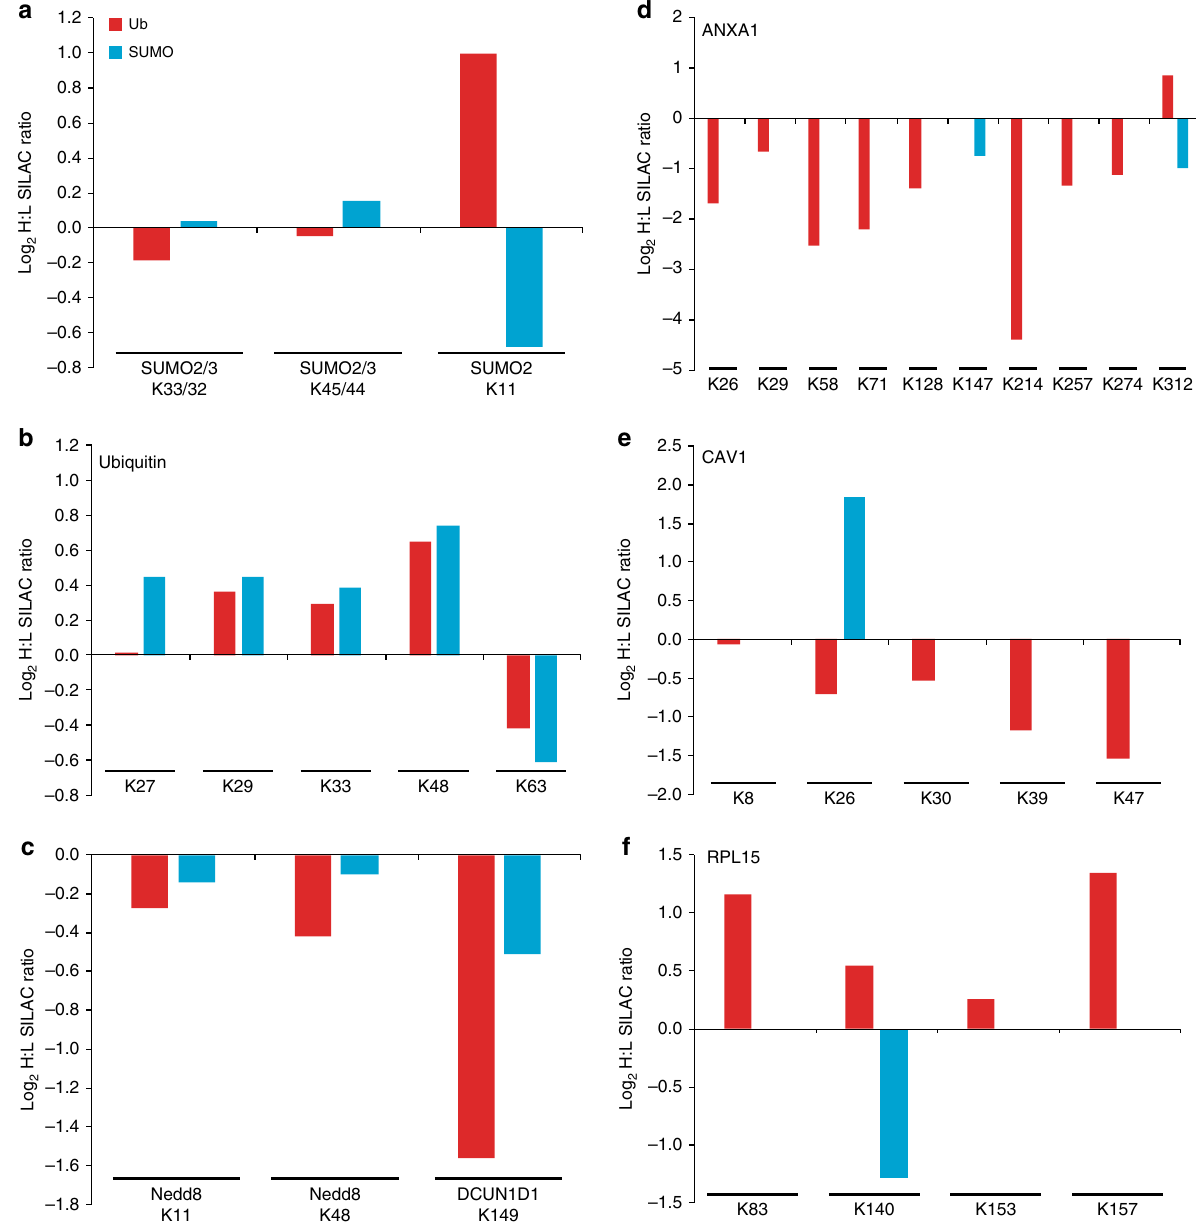
Fig. 5 Log 2 SILAC ratios (heavy-MG132-treated:light-untreated HCT116 cells) for quanti fi ed ubiquitin (red) and SUMO (blue)-modi fi ed peptides observed on SUMO-2/3 ( a ), ubiquitin ( b ) Nedd8 and DCN1 ( c ), annexin-1 ( d ), caveolin-1 ( e ), or RPL15 ( f ). The position of the modi fi ed lysine is